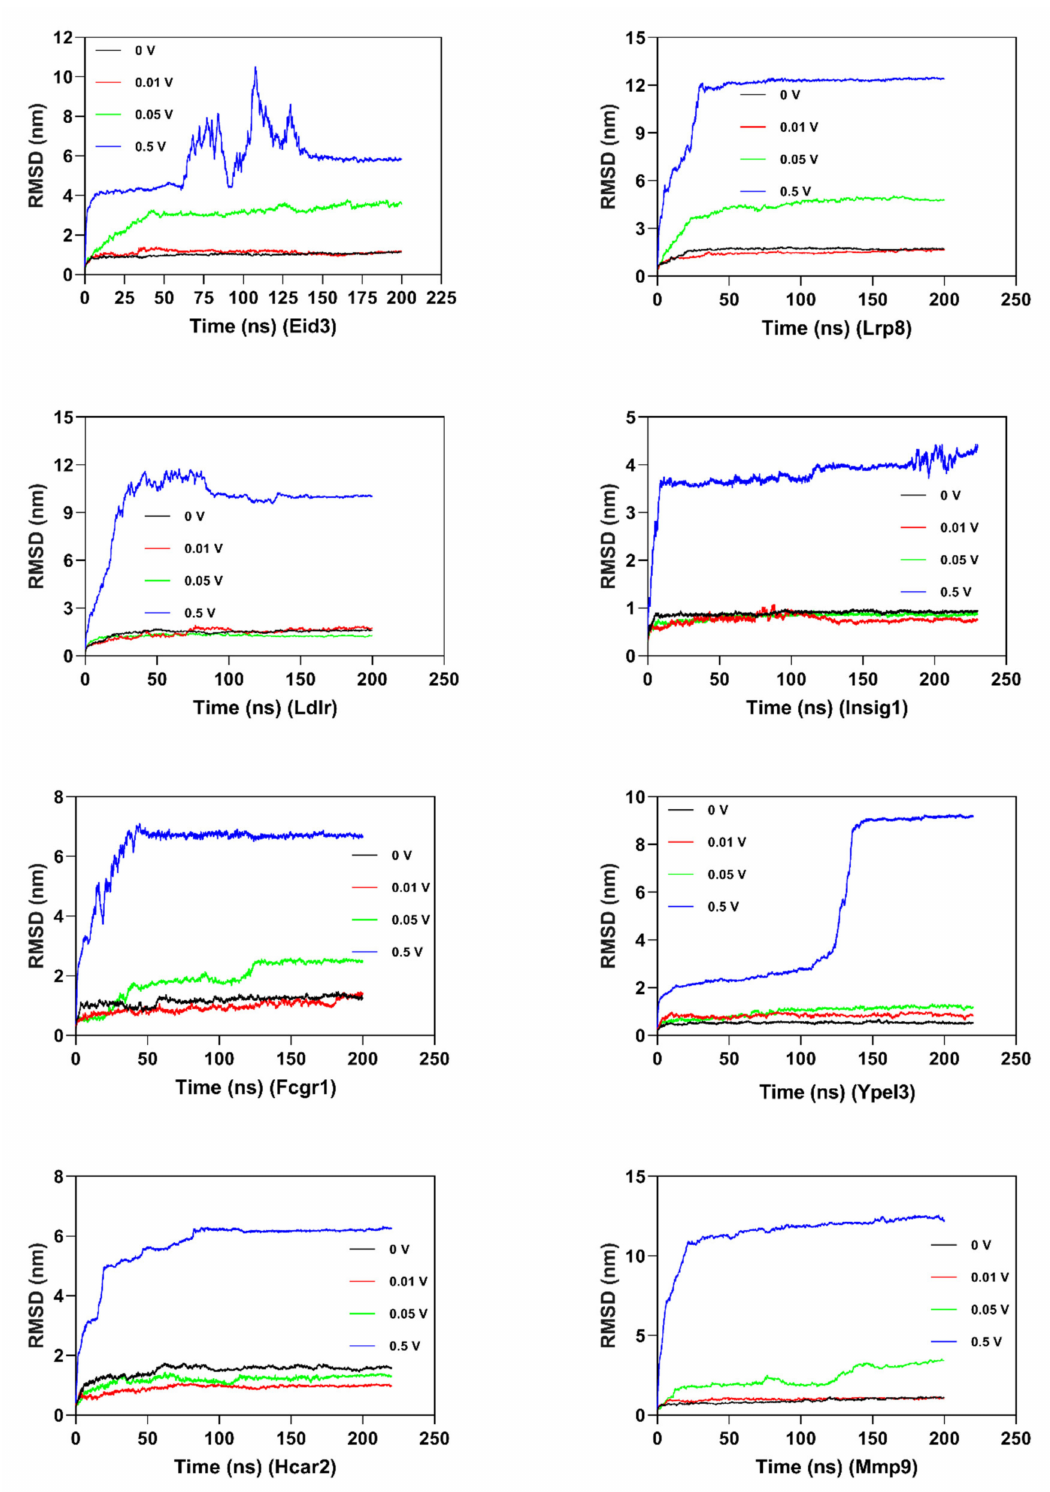
Figure 7. Root mean square deviation (RMSD) comparison plots of backbone C α atoms during molecular dynamics simulation (at least > 200 ns). In order to clearly illustrate the deviations of the DEG proteins, the RMSD plots are shown. The RMSD of Eid3, Lrp8, Ldlr, Insig1, Fcgr1, Ypel3, Hcar2, and Mmp9 are shown. For each protein, 0 mV (black), (red), 50 mV (green), and 500 mV (blue) are displayed on the